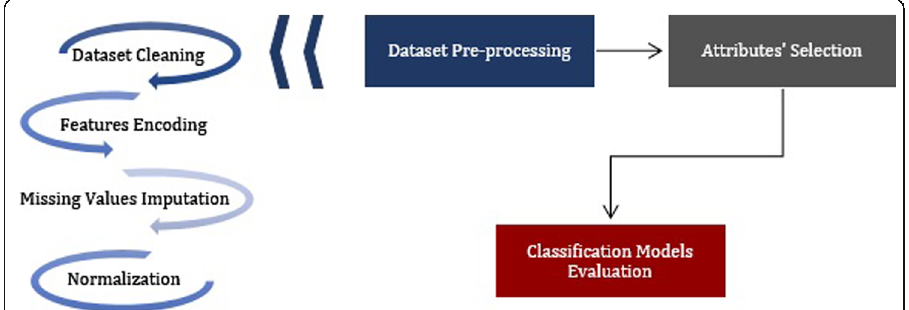
Fig. 1 Dataset analysis